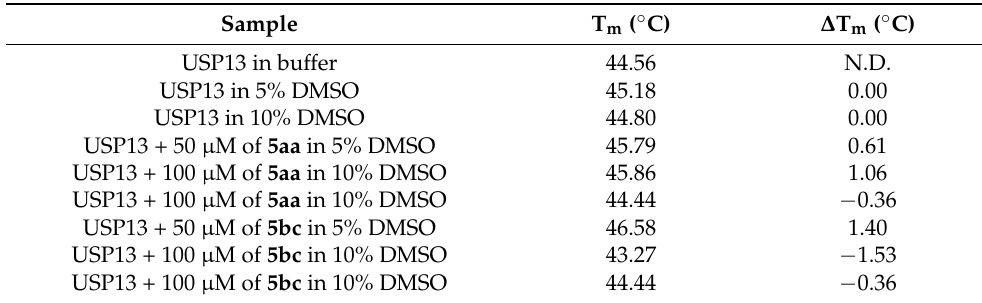
Table 1. Melting temperatures, Tm ( ◦ C), and the thermal shift, ∆ Tm ( ◦ C), are given for each sample analyzed in a thermal shift assay. The melting temperatures were derived by fitting a Boltzmann– sigmoidal equation to the data. To determine a temperature difference ( ∆ Tm), the reference condition was the protein in buffer with the corresponding percentage of DMSO. Sample T m ( ◦ C) ∆ T m ( ◦ C) USP13 in